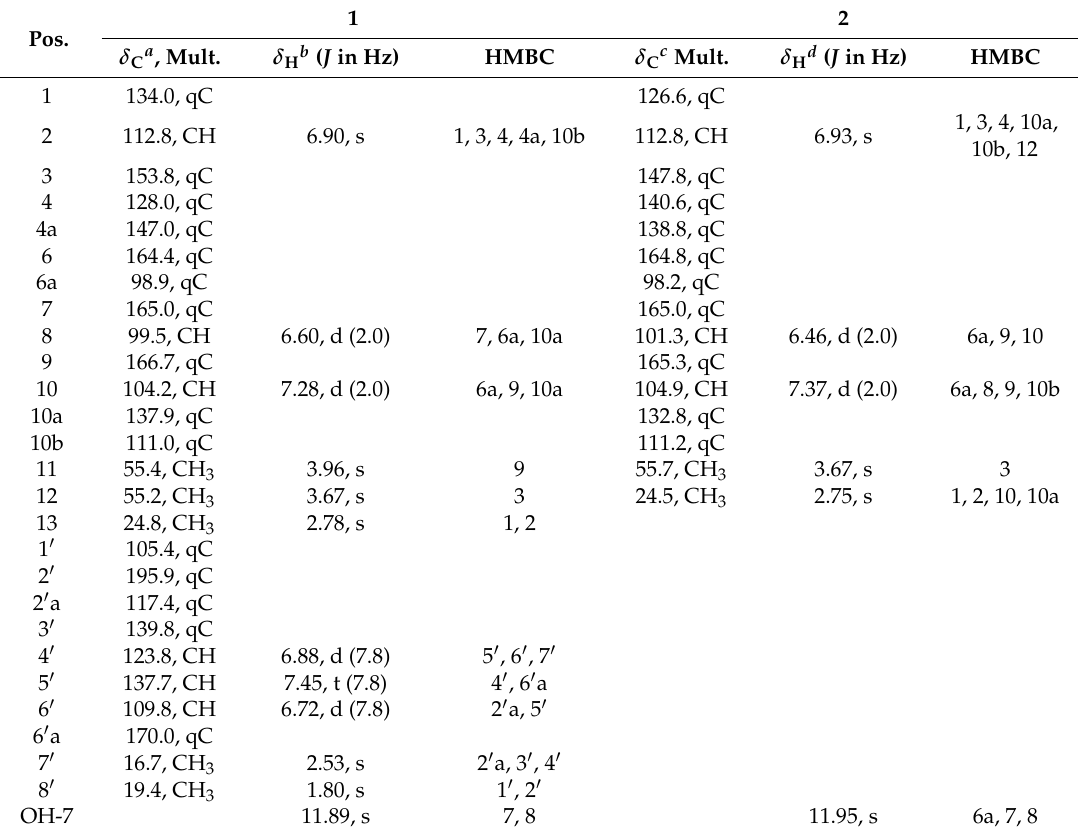
Table 1. NMR data for 1 and 2 .